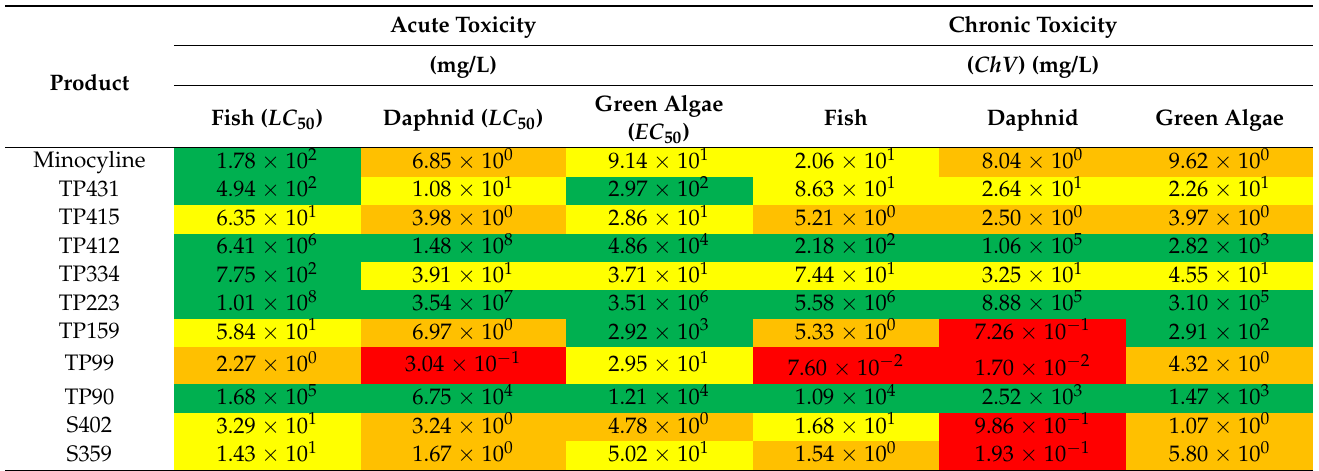
Figure 6. Possible photocatalysis pathways of minocycline degradation using PVDF–PVP–TiO 2 5% fiber mats. S402, S359 are not actually determined. Table 1. Toxicity evaluation of the intermediates of minocycline using a QSAR